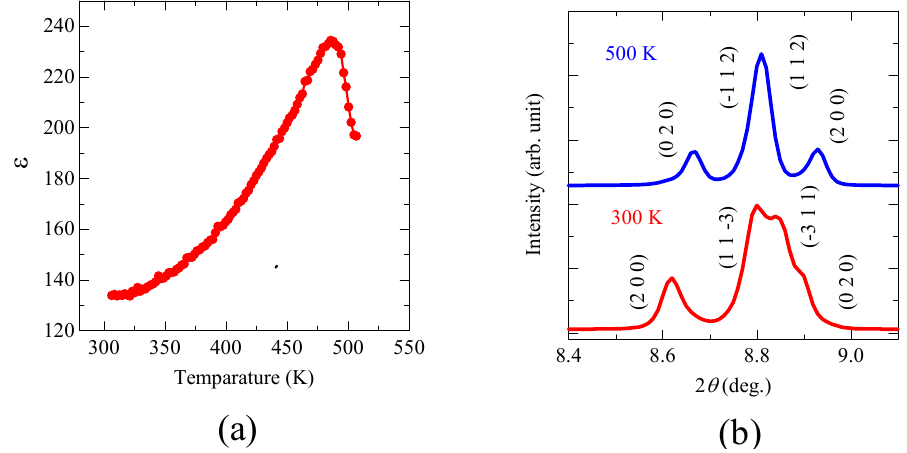
Figure 3. (a) Temperature dependence of dielectric constant of Bi kHz. A peak at 485 K indicates the ferroelectric Curie temperature; (b) Powder X-ray diffraction patterns taken at 300 and 500 K. The indices of the diffraction pattern at 300 K are for the noncentrosymmetric C 2 structure, while those at 500 K for the centrosymmetric / n structure. The results clearly show the ferroelectric transition at 485 K of monoclinic P 2 1 Bi NiMnO 2 6